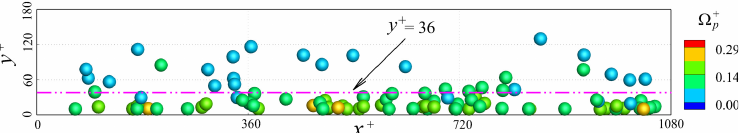
Figure 9. Side view snapshot of the particle positions taken from case φ = 0.44%, particles are colored by their angular velocities. Animations can be found in video S1 in the supplementary